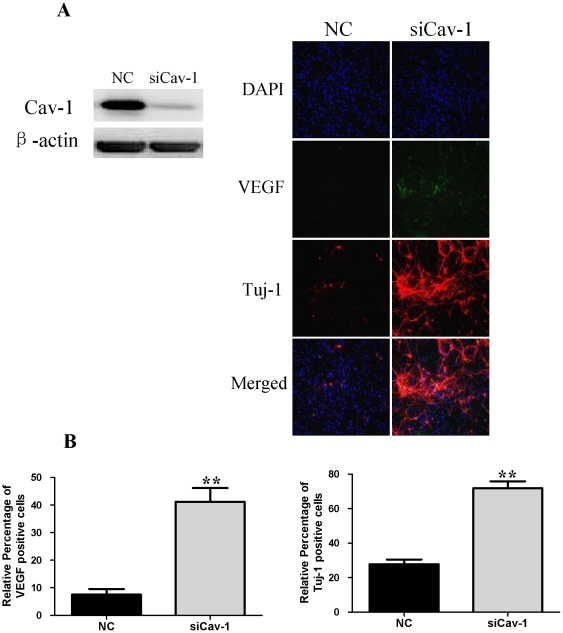
Effects of siRNA Cav-1 specific knockdown on the expressions of Tuj-1, VEGF in NPCs with or without V1 treatment under normoxic condition.A short interfering RNA transfection was used to knock down the expression of Cav-1 in NPCs. NPCs were transfected with Cav-1 Stealth™ RNAi. All data were obtained at day 14. A. Representative results of the expressions of Cav-1, Tuj-1 and VEGF. Left, the expression of Cav-1 was successfully knocked down by the Cav-1 RNAi; Right, immunofluorescent imaging of VEGF and Tuj-1, Green color: VEGF staining. Red color: Tuj-1 staining. Nuclear localization of VEGF and Tuj-1 was verified by co-localization with DAPI staining (blue color). NC, negative control group; siCav-1, Cav-1 RNA silencing group; B. Statistical analysis on the relative percentage of VEGF and Tuj-1 positive cells in NPCs (Mean ± S.D., n = 6). siCav-1 versus NC, **p<0.01.